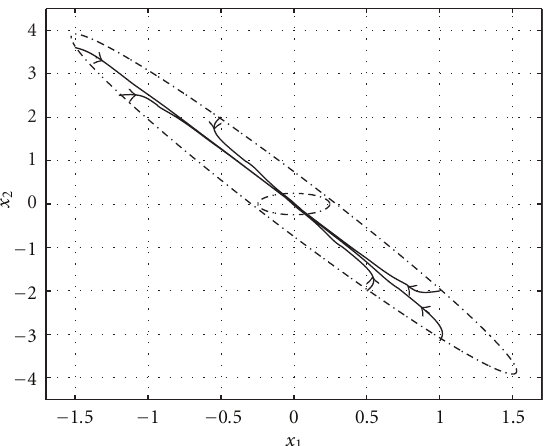
Figure 1: Trajectories and ellipsoid D e for a maximum delay of h m = 1 .